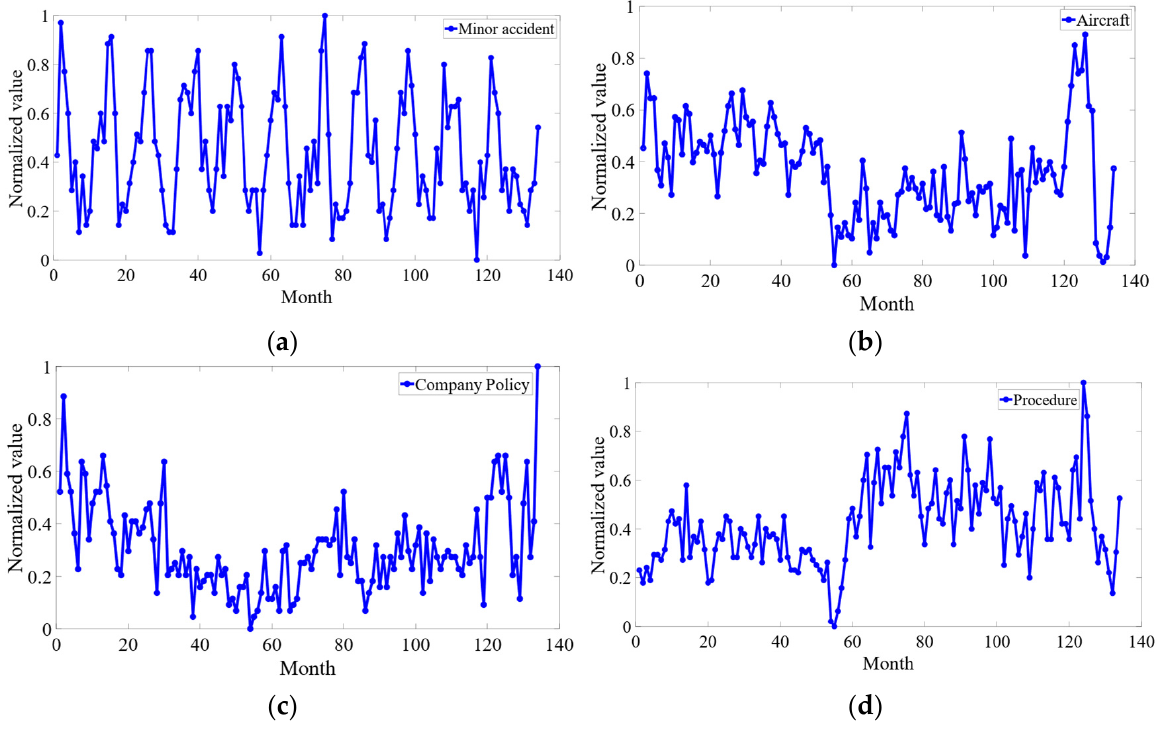
Figure 8. Sequence diagram for ( a ) MA, ( b ), A ( c ) CP, ( d ) P.